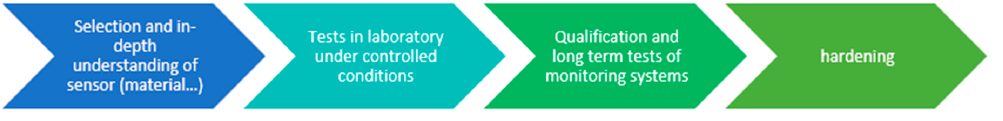
Figure 3. Sensing chain qualification methodology.